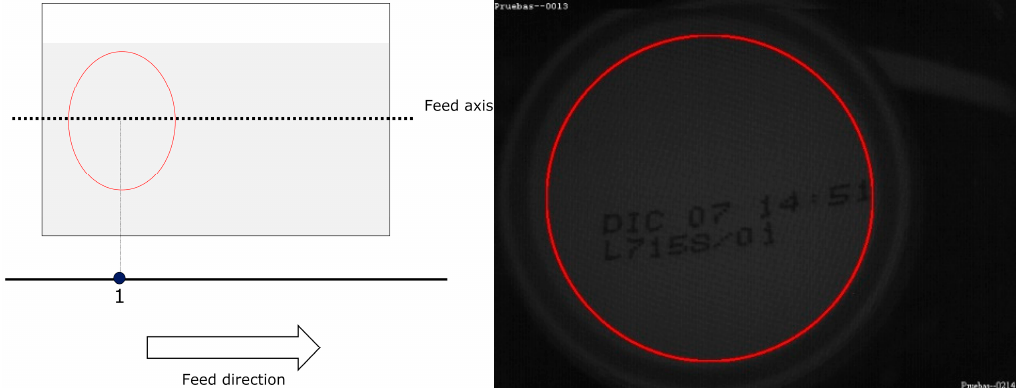
Figure 9. The “Enter” event occurs, and the system goes into the Can state.